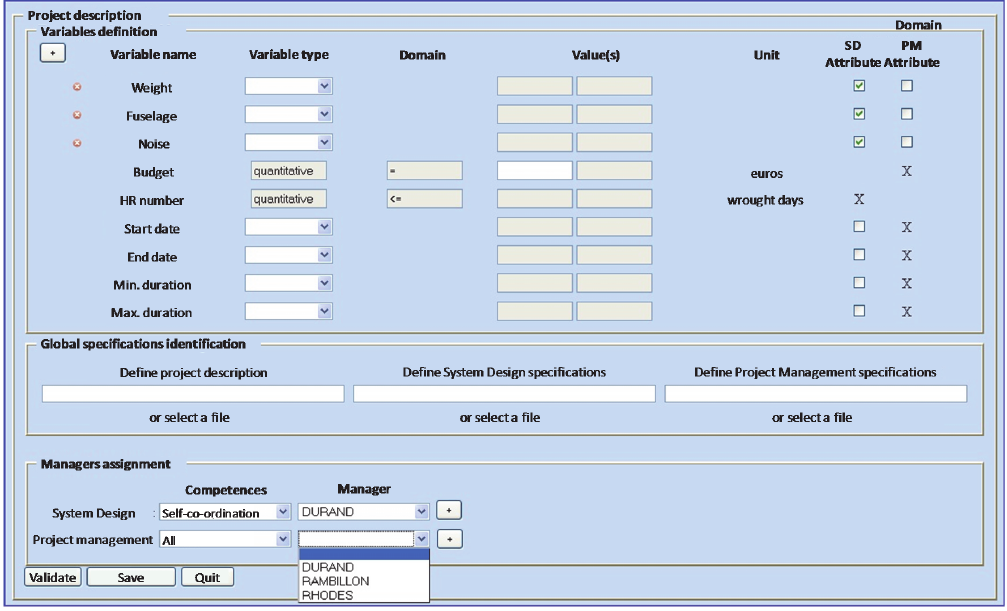
Fig. 7. Competences and